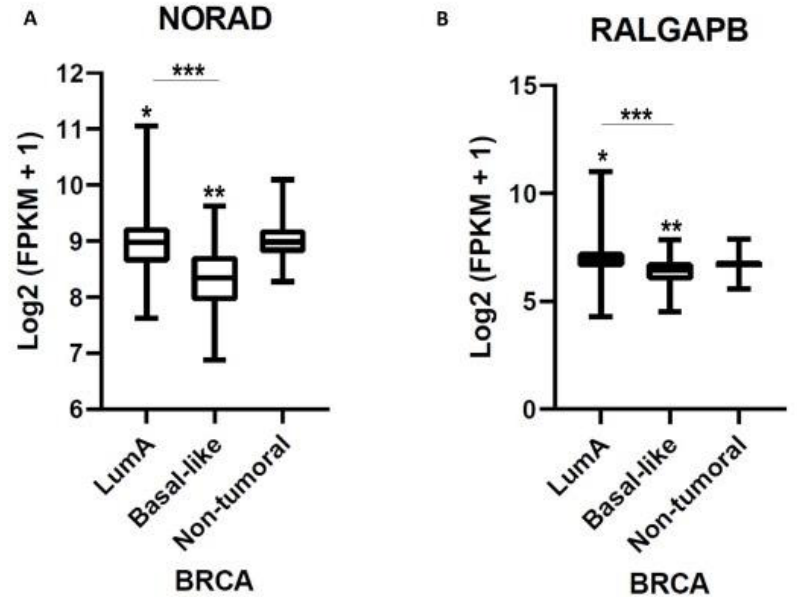
Figure 3. Differential expression of NORAD lncRNA and RALGAPB for Lum A and Basal-like subtypes. Legend: ( A ) Differential expression of NORAD lncRNA in comparing Lum A, Basal-like subtypes, and non-tumor samples. (NORAD) Lum A—Log 2 FC = 0.254, * p = 1.19 × 10 − 16 , Basal-like—